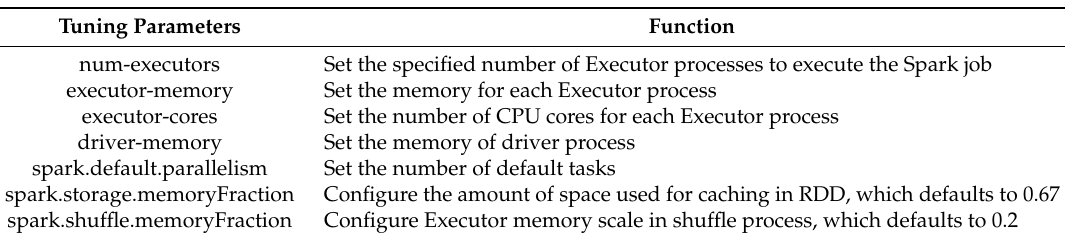
Table 5. Resource parameter